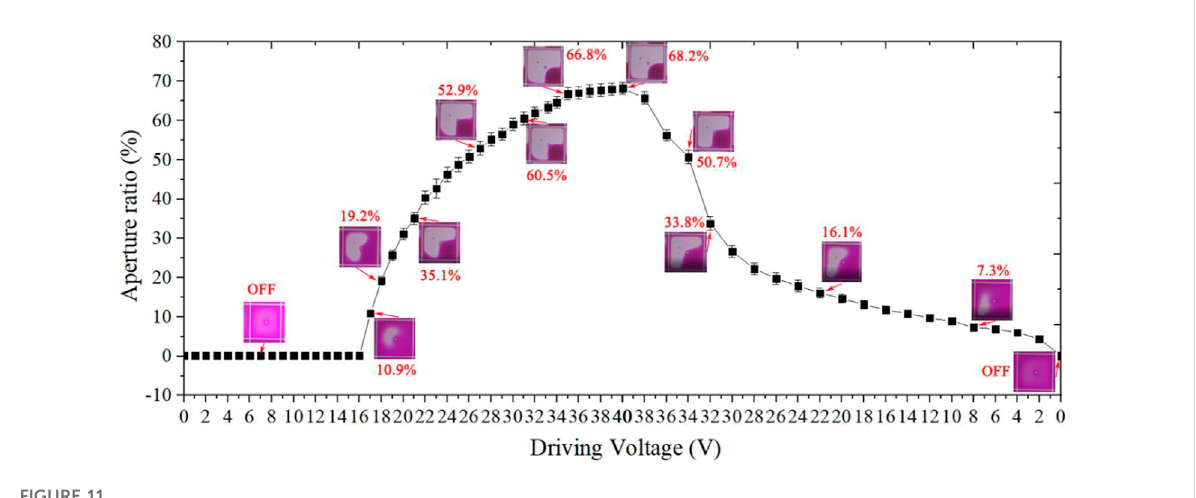
FIGURE 11 Pixel aperture ratio values with different driving voltages.